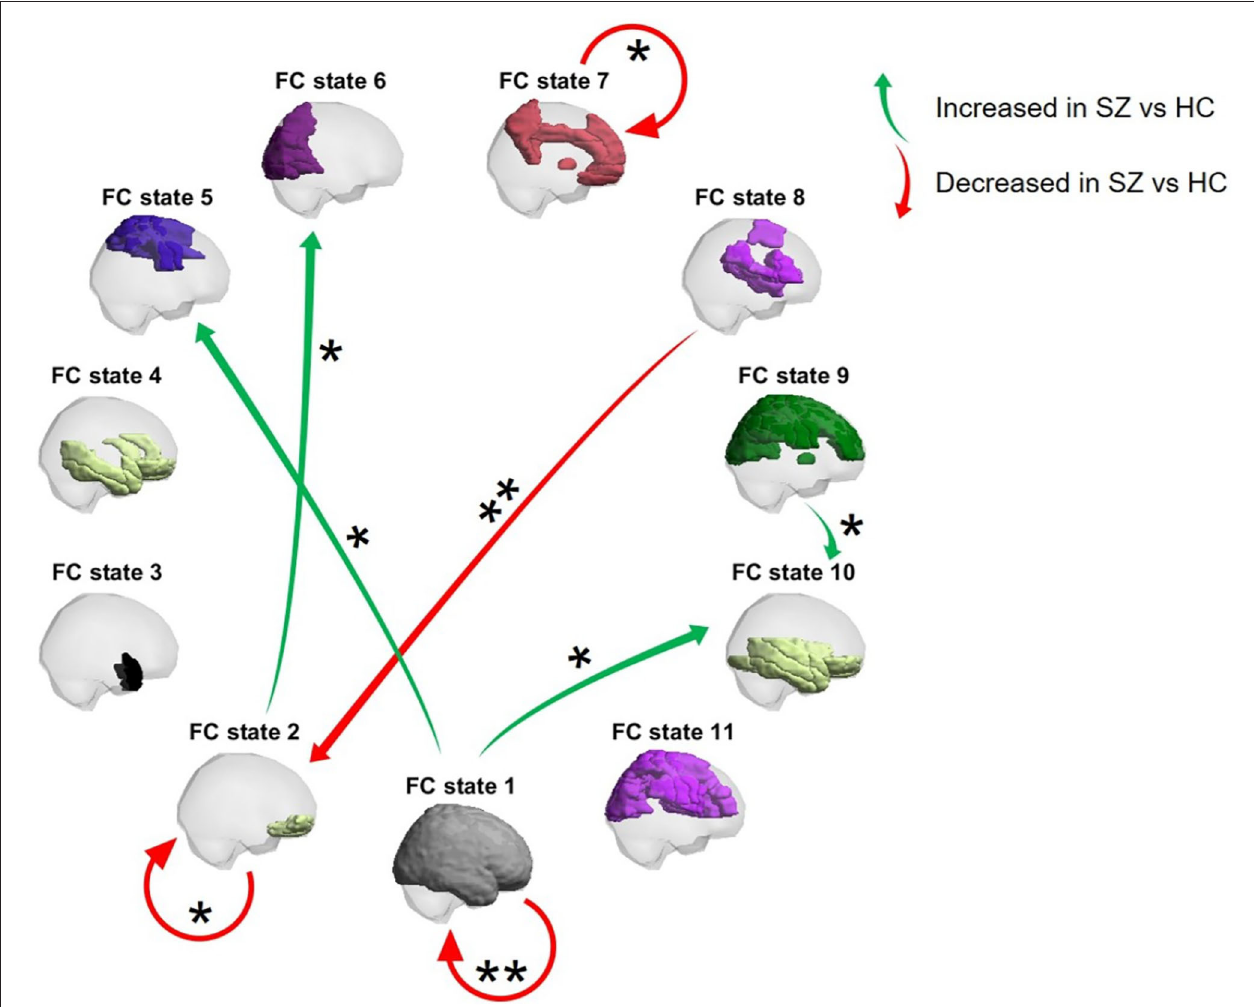
FIGURE 5 | Transition diagram of the state-to-state transitions significantly altered in SZ patients compared to HCs. Arrows represent a mean transition probability that was significantly increased (green) or decreased (red) in SZ patients compared to HCs. Single and double asterisks indicate, respectively, significant intergroup differences with p < 0.05 / 11 and p < 0.05 / (11 × 11) (one-tailed